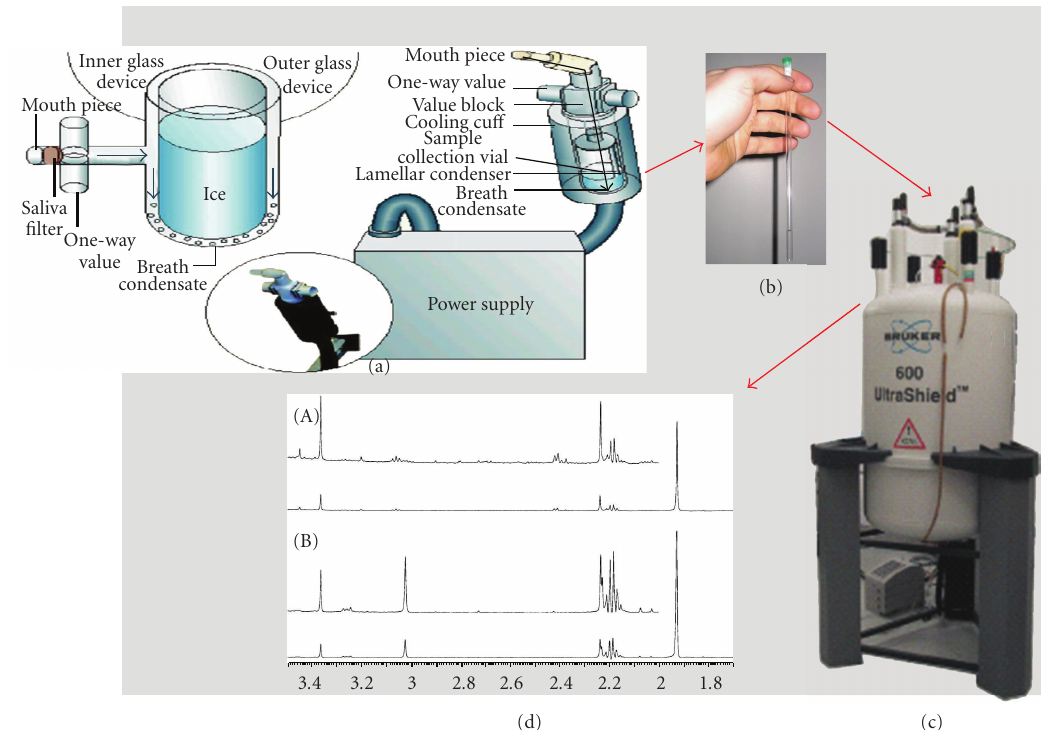
Figure 1: Metabonomics of EBC using NMR. The exhaled breath is cooled in (a), then transferred into the NMR tube (0.5–0.7mL) (b) and put in the spectrometer (c) to collect the spectra